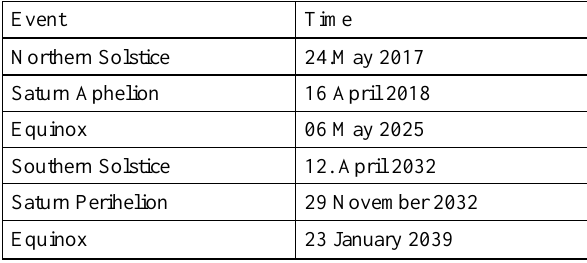
Table 3: Saturn/Enceladus solar orbits and key events